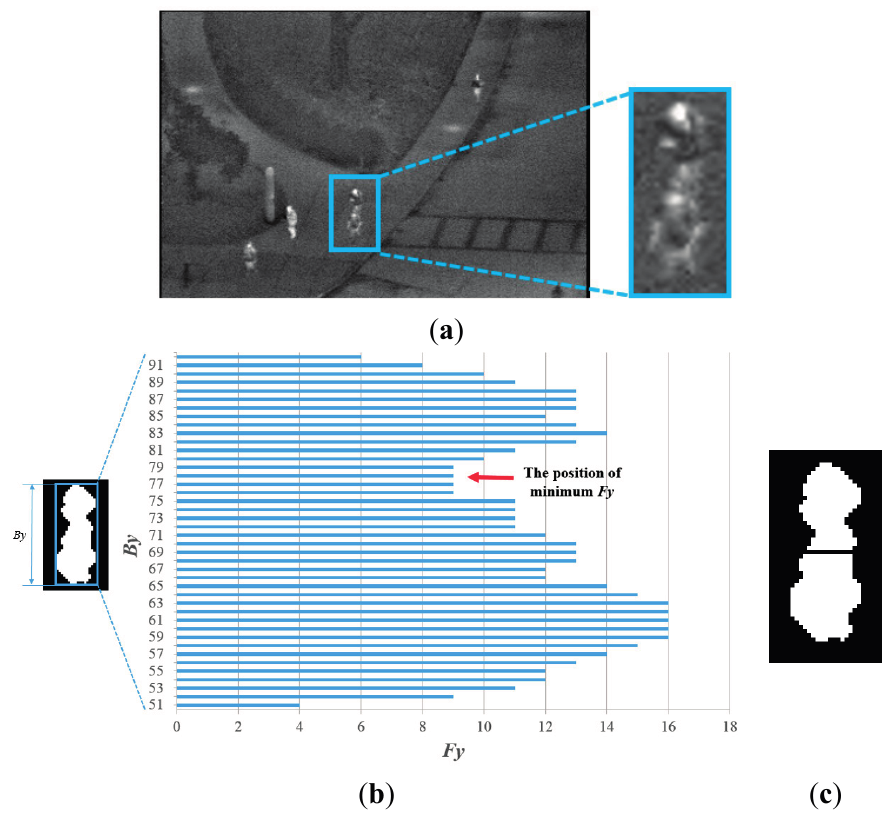
Figure 8. Division of the candidate region within an input image based on the vertical histogram: ( a ) input image; ( b ) detected candidate region and its vertical histogram; and ( c ) the division result of the candidate